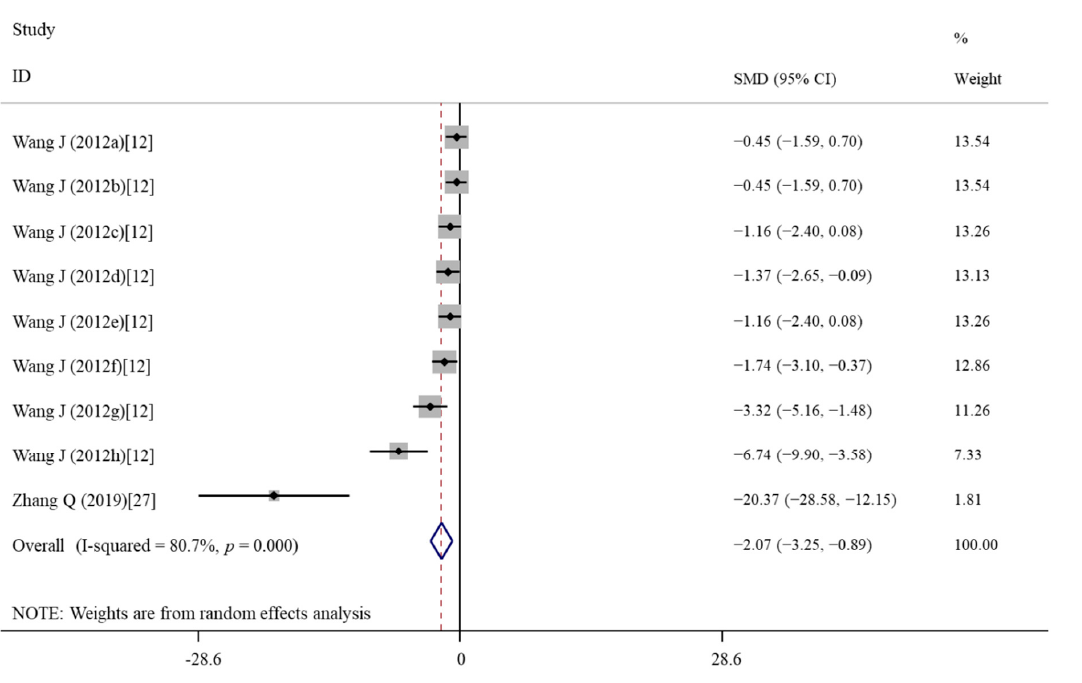
Figure 3. Forest plots showing the protective effects of vitamin E on Caspase-3 levels of cells compared with the nanomaterial exposure group. a, b, c, d of the study of Wang et al. represent treatment with 50, 500, 1000, 2000 µ M of vitamin E for 24 h; e, f, g, h of the study of Wang et al. represent treatment with 50, 500, 1000, 2000 µ M of vitamin E for 48 h. SMD, standardized mean difference; CI, confidence interval [12,27].